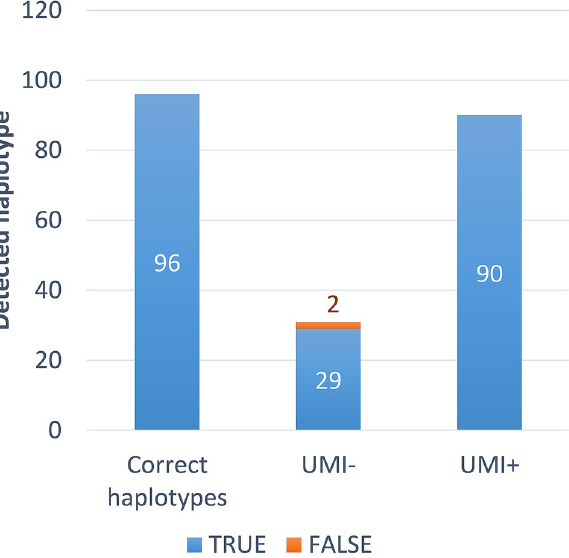
Figure 5. HaCeD-Seq analysis results for the aquarium tank water. The correct number of haplotypes is 96 but only 90 haplotypes were detected when using the UMI tags (UMI+). Only 29 haplotypes and two false haplotypes were detected without the UMI tags (UMI−).